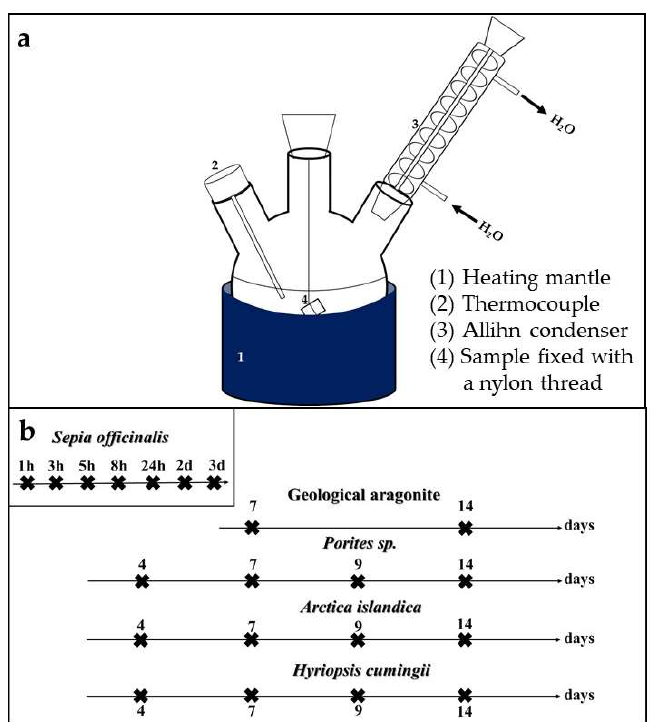
Figure A1. ( a ) Experimental setup; ( b ) overview of conducted conversion experiments. Sepia officinalis cuttlebone was transformed for 1 to 24 h and 2 and 3 days. Porites sp., Arctica islandica and Hyriopsis cumingii aragonite were transformed up to 14 days. Geological aragonite was transformed for 7 and